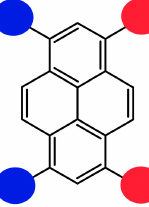
Figure 1. 1,3,6,8-Tetrasubstituted pyrene with the substitution pattern providing the long axial